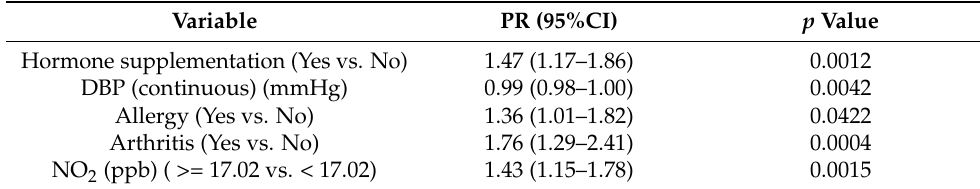
Table 5. Stepwise logistic regression